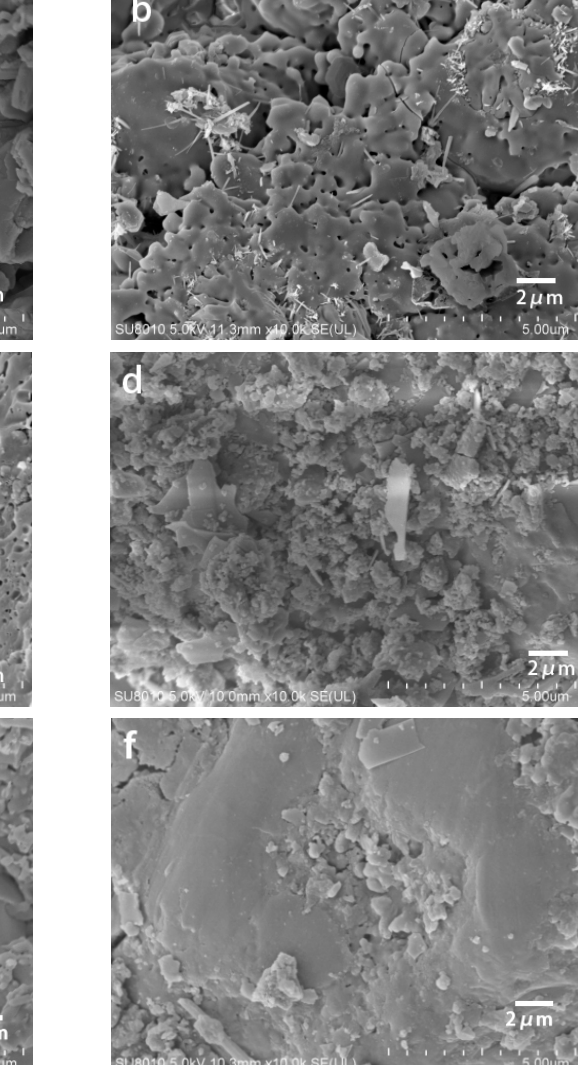
Figure 3. SEM images of Surface morphology of monolithic geopolymer ceramics; ( a ) KGPs 1200 °C, 4 h, without KCl salt; ( b ) KGPs 1200 °C, 6 h, without KCl salt; ( c ) KGPs 1200 °C, 8 h, without KCl salt; ( d ) KGPs 900 °C, 4 h, with KCl salt; ( e ) KGPs 900 °C, 6 h, with KCl salt; ( f ) KGPs 900 °C, 8 h,